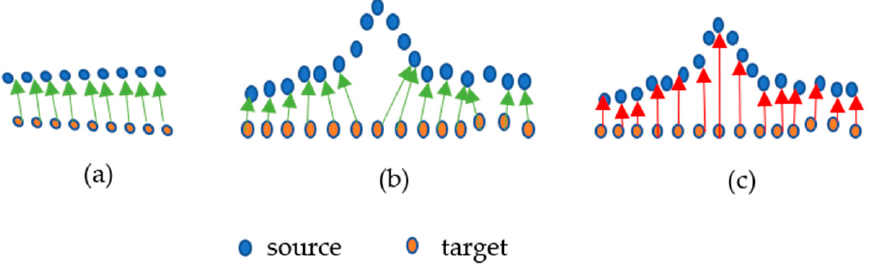
Figure 5. Scenarios ( a ). Smooth ( b ). Non smooth and ( c ). Actual of finding the corresponding changed point from target to source.